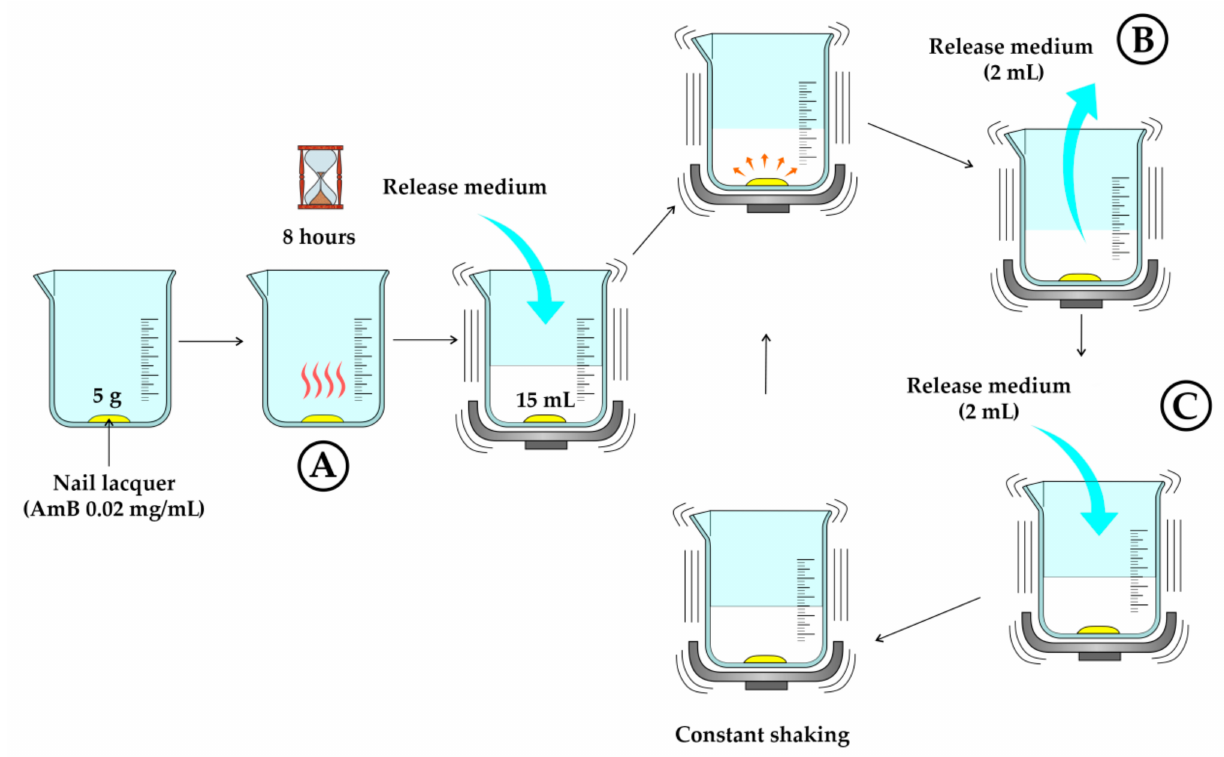
Scheme 3. Graphical illustration of the in vitro AmB-loaded nail lacquer’s drug release. ( A ) The nail lacquer was applied and left to dry for 8 h. For the release assay, 2 mL of the medium was collected at each time interval for AmB quantification ( B ) and immediately replaced by fresh medium ( C